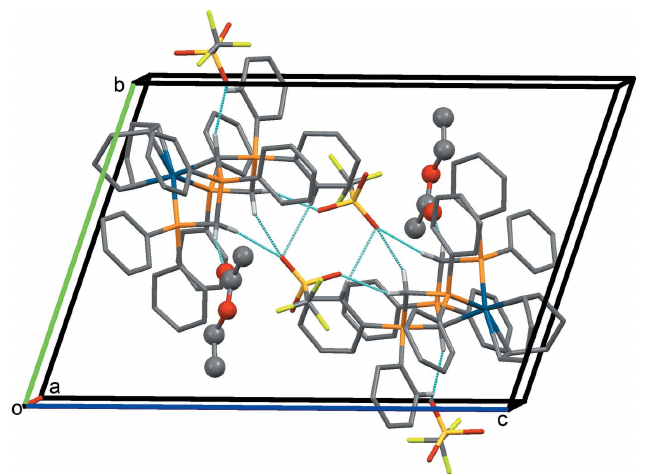
Figure 5 Aview along the a axis of the crystal packing of compound 1b . Only the H atoms involved in the most significant intermolecular interactions (Table 2) have been included. The ethyl acetate solvate molecule is shown in ball-and-stick mode.